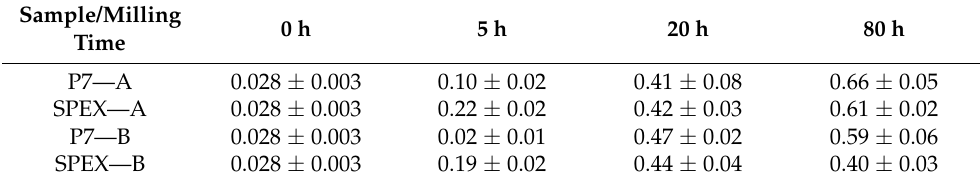
Table 3. Microstrain, ε (%), of the cubic bcc Fe main